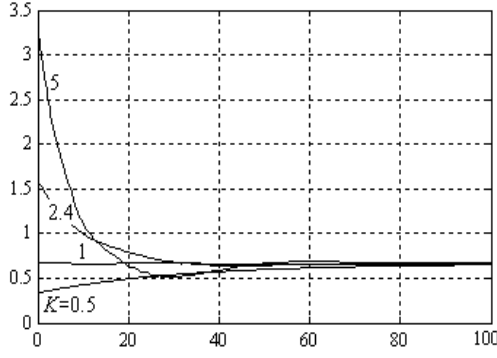
Figure 11. Control responses u ( t ) to a unit step reference for K = 0.5; 1; 2.4; 5.